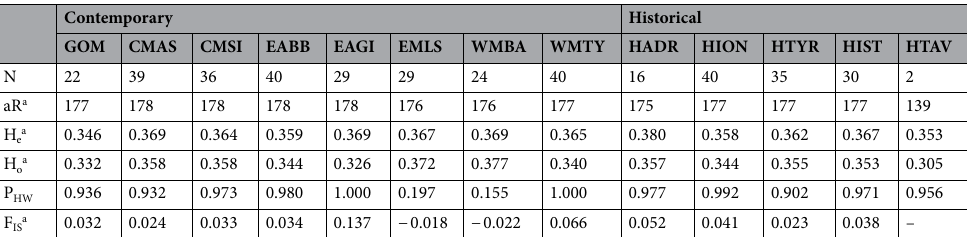
Table 1. Genetic diversity, Hardy–Weinberg deviation, and F IS in contemporary and historical (archival and archaeological) sample groups. n, number of samples analysed, aR, allelic richness; H e , mean expected heterozygosity; H o , mean observed heterozygosity; P HW , P value of the Hardy–Weinberg equilibrium deviation test; F IS , inbreeding coefficient. a All unpaired t-test values between contemporary and historical samples (excluding GOM, HTAV) were non-significant.